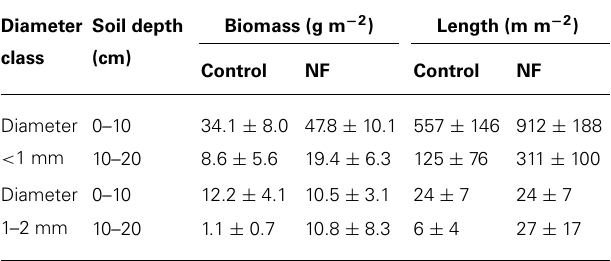
Table 3 | Biomass and length of fine roots of sugi at control and nitrogen-fertilized (NF) plots.